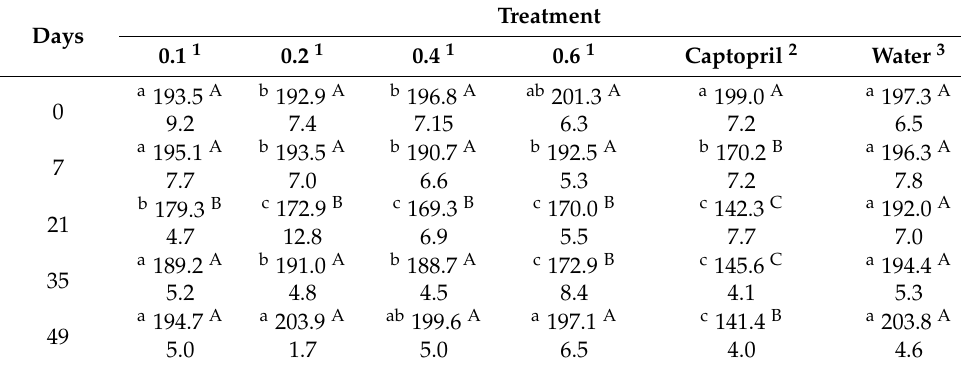
Table 6. LsMean and SEM of diastolic blood pressure in different groups of